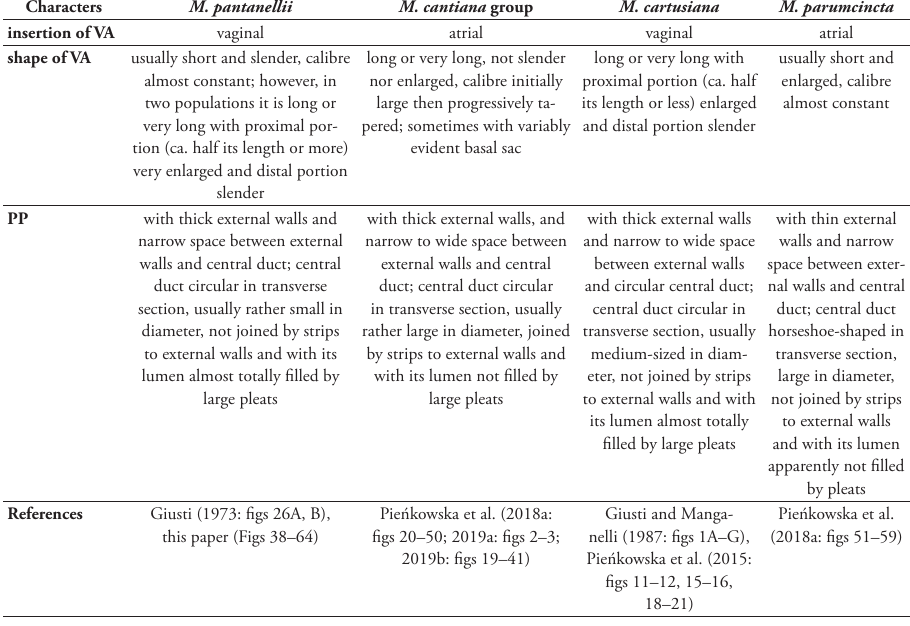
Table 7. Other anatomical features distinguishing Monacha